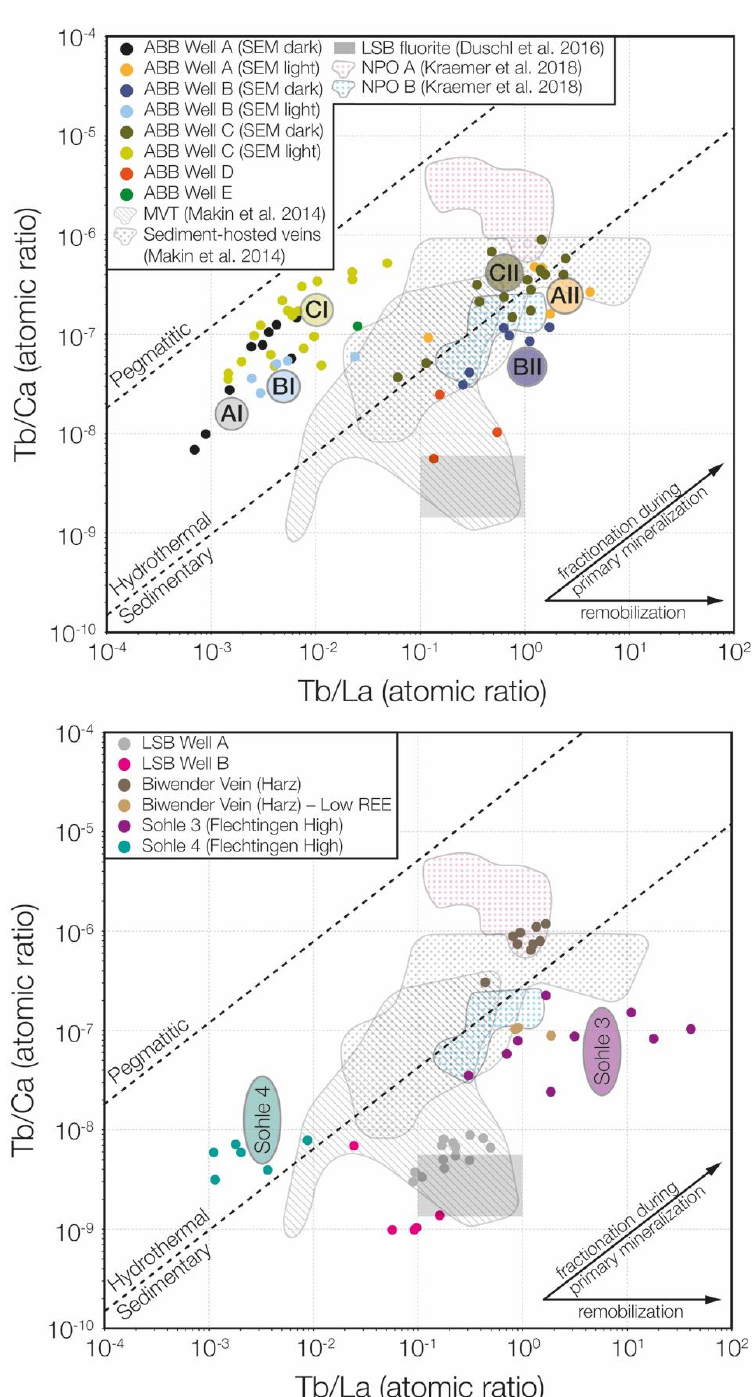
Figure 9. Tb/La versus Tb/Ca atomic ratio diagram after Möller et al. [33] for fluorite from the ABB, LSB, Biwender Vein (Harz), and Flechtingen High. For reference, fields compiled and established by Makin et al. [28], Duschl et al. [11], and Kraemer et al. [43]—North Pennine Ore Field (NPO), Alston Block (A) and Askrigg Block (B) are plotted. Labels, groupings and colours in the diagram (e.g., AI, Sohle 3) correspond to sample populations shown in Figures 4 and 5. See text for